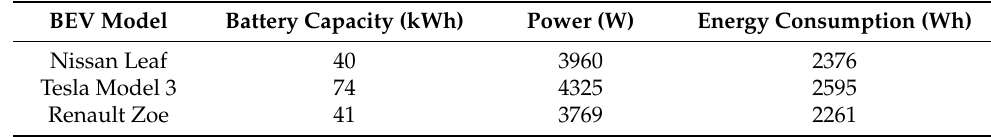
Table 3. Energy consumption for the short-distance